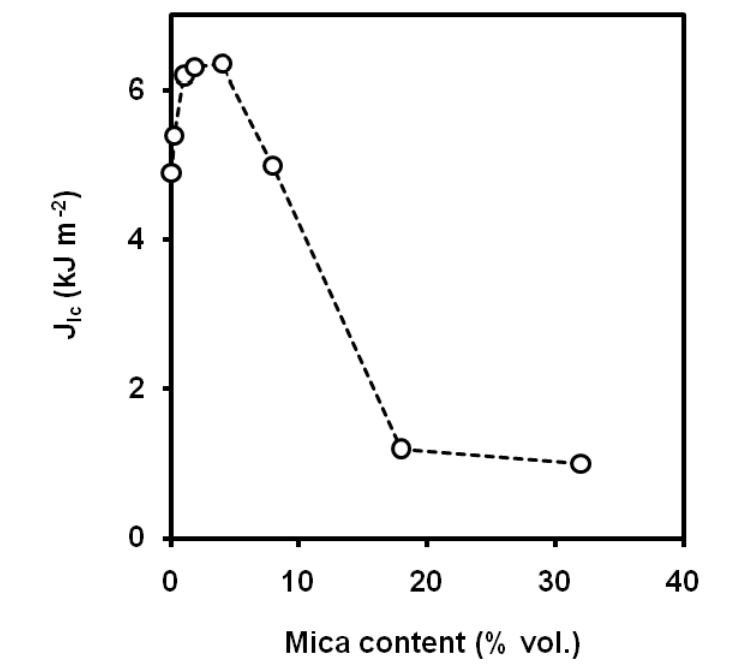
(adapted from Ic